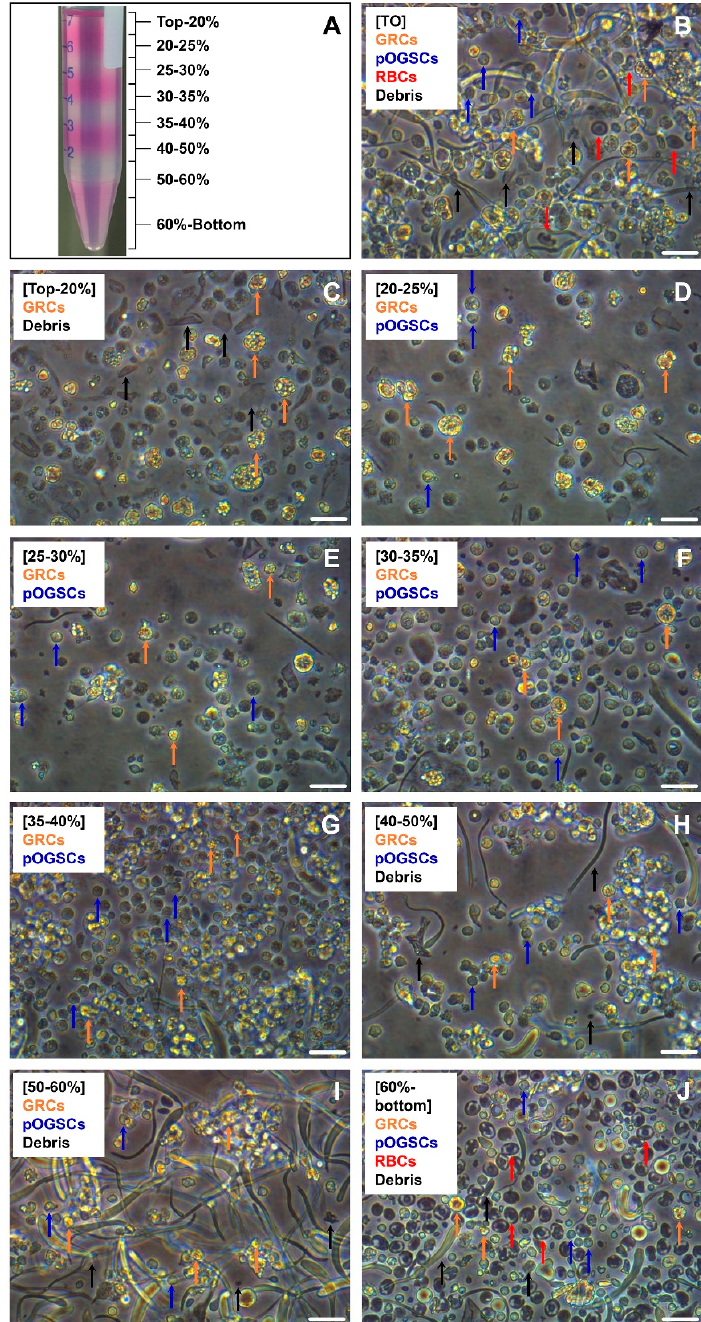
Figure 1. Separation of medaka ( Oryzias latipes ) crude ovarian cell populations by Percoll density gradient centrifugation (PDGC). Ovarian cells obtained from 10 adult females by mechanical and enzymatic dissociation were subjected to PDGC to separate the cells depending on their density. ( A ) Picture taken after PDGC. Density fractions from the top–20%, 20–25%, 25–30%, 30–35%, 35–40%, 40–50%, 50–60%, and 60%–bottom were collected separately, and the cells in each fraction were observed with an inverted microscope. ( B ) Image of the crude total ovarian cell population (TO) before cell separation. Granule-rich cells (GRCs), putative ovarian germline stem cells (pOGSCs), red blood cells (RBCs), and debris were observed. ( C–J ) Images of the cells from each density fraction after PDGC. pOGSCs were most abundant in 30-35% density fraction, and a lot of GRCs were identified in 35–60% density fractions. RBCs were concentrated in the 60%-bottom fraction, and tissue debris was abundant in the top–20% and 50–bottom fractions. Scale bar = 20 µm.